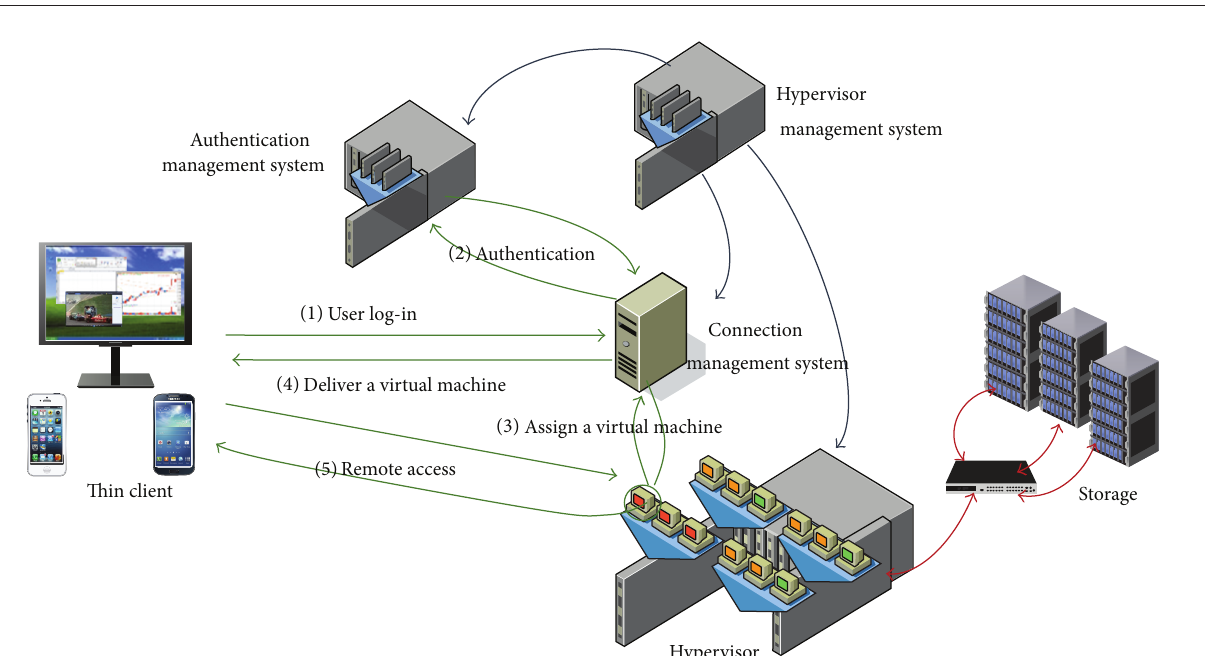
Figure 2: General VDI structure.